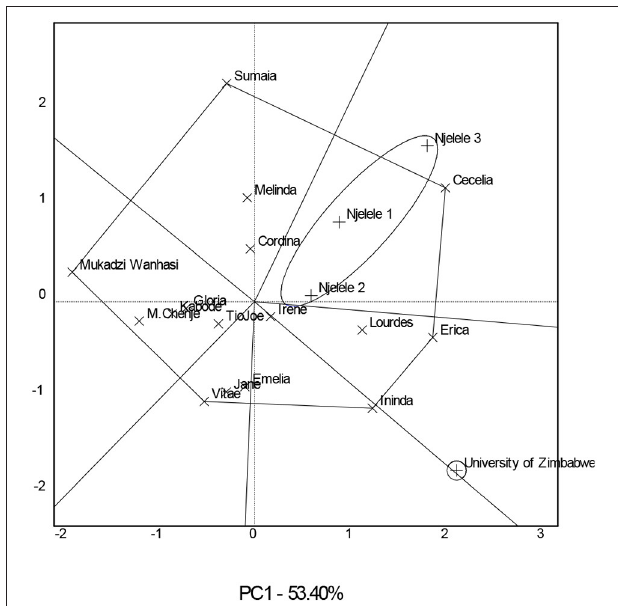
FIGURE 2 | A which-won-where biplot showing mega environments for the 16 sweetpotato genotypes evaluated in four environments.